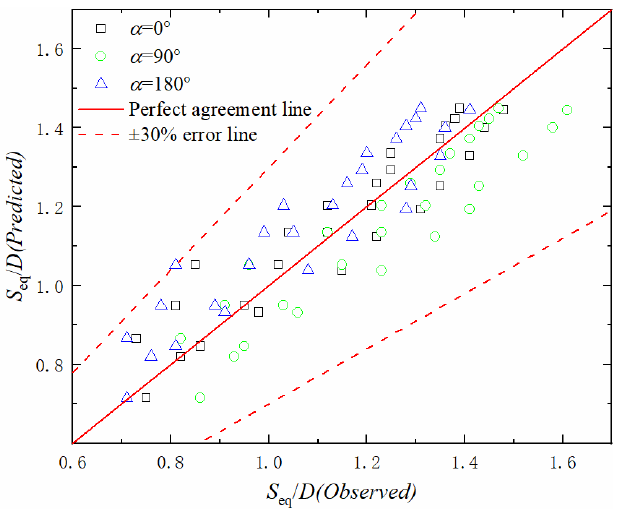
Figure 9. The relationships between S eq / D and F r for different installation angles and fitting results.